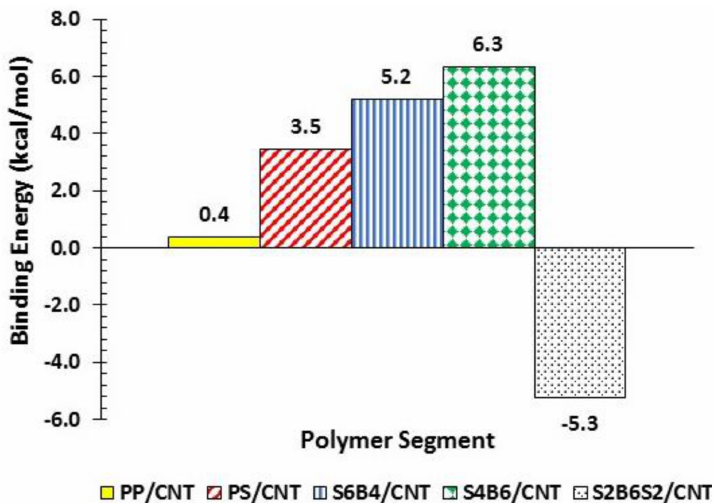
Figure 3. Binding energy of the polymer/CNT and copolymer/CNT